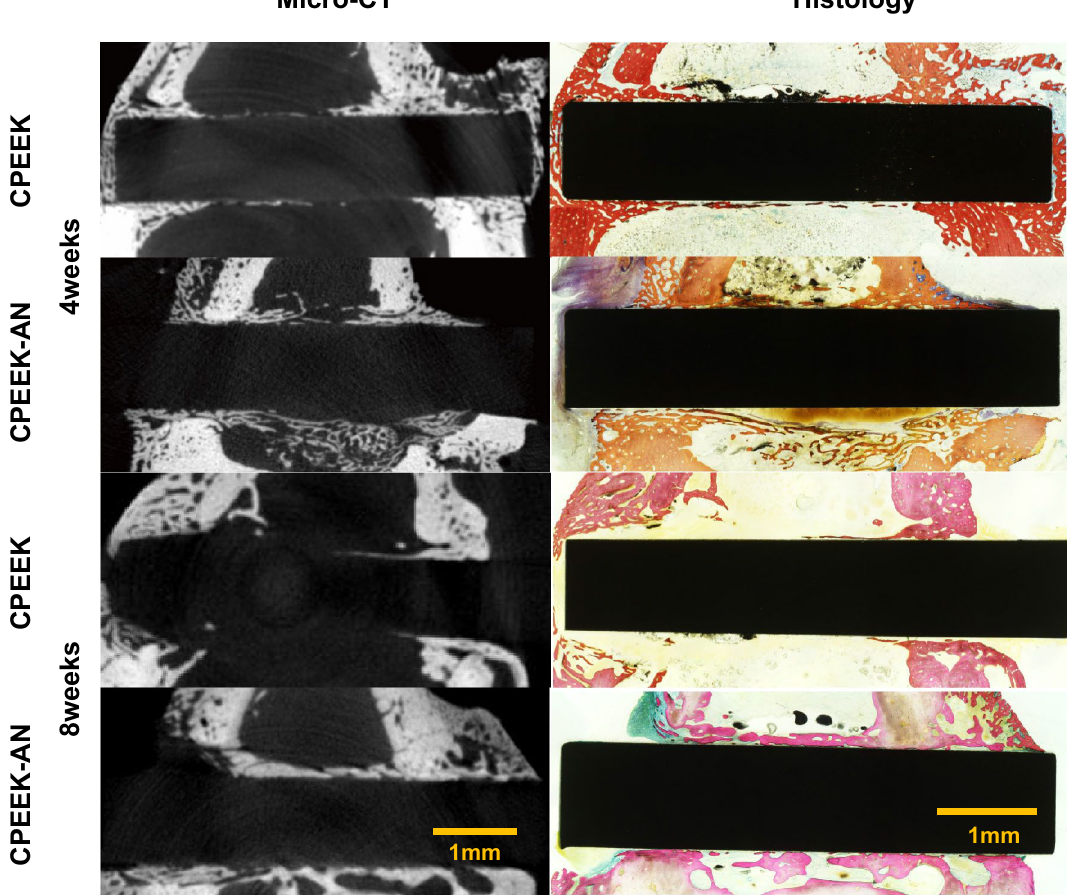
Figure 6. Interfacial evaluation1. Micro-CT images and the corresponding histological images of the specimen at 4 and 8 weeks after